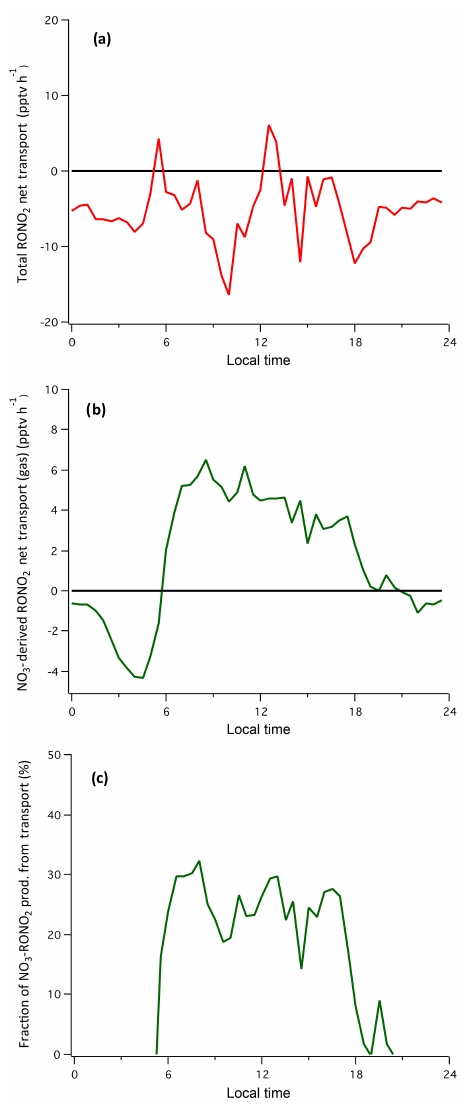
Figure 10. (a) Net transport of total gas-phase RONO 2 above the canopy. Positive indicates transport from the below-canopy envi- ronment; negative indicates transport to the below-canopy environ- ment. (b) Same as (a) , but for RONO 2 produced solely from NO 3 oxidation of BVOCs. (c) Percent of total production of NO 3 -derived RONO 2 species above the canopy resulting from net transport from the below-canopy environment. This figure implies downward net transport of OH-derived RONO 2 species and upward net transport of NO 3 -derived RONO 2 species.